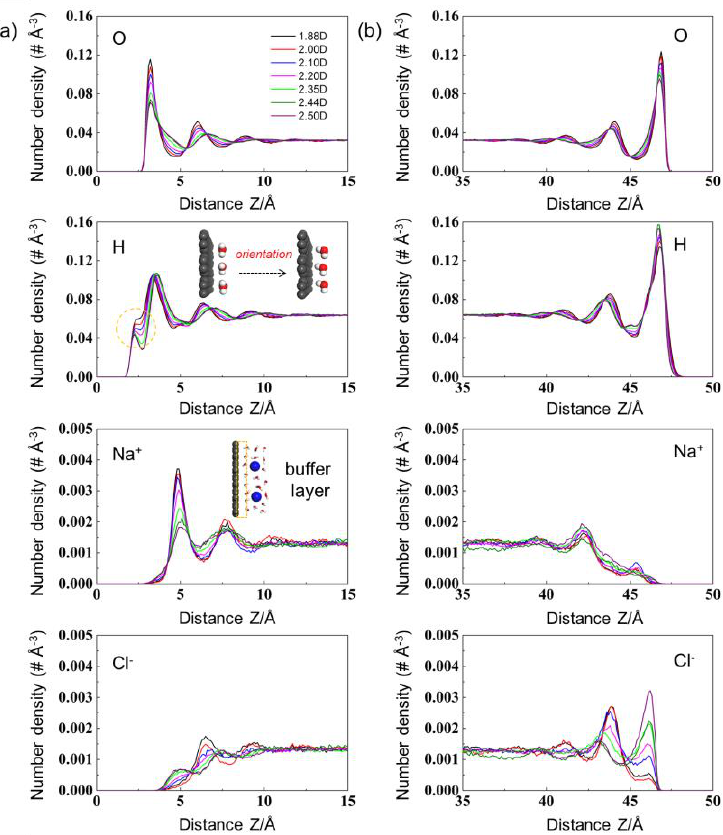
Figure 2. Number density profiles of electrolytes for graphene electrodes at the surface charge densities of ( a ) − 5 µ C cm − 2 and ( b ) +5 µ C cm − 2 .